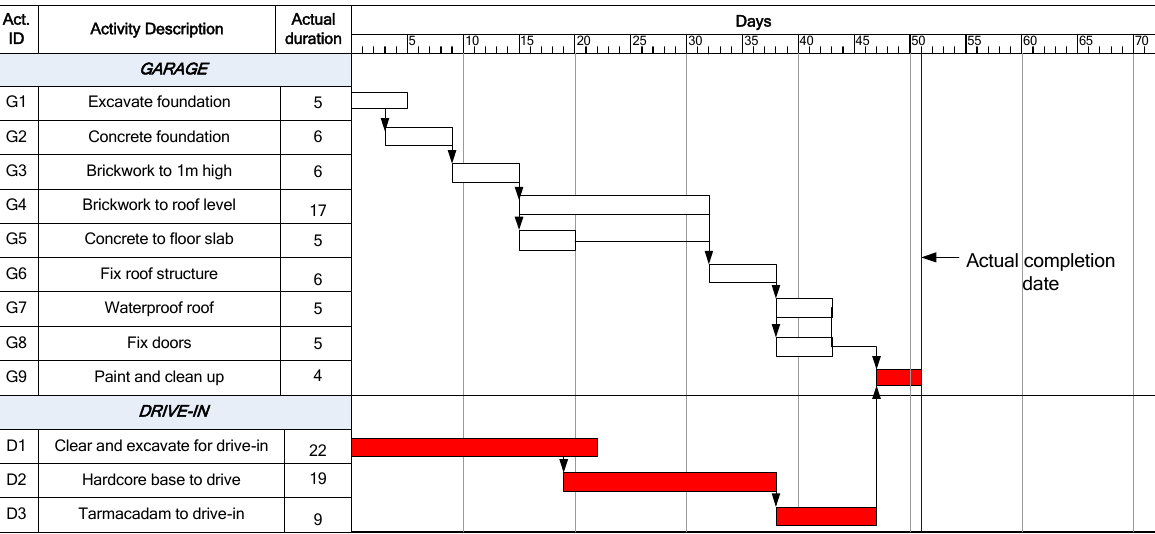
Figure 3. As-built